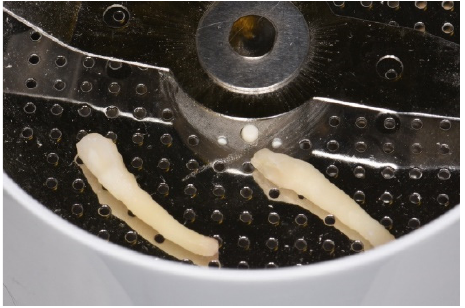
Figure 6. Grinding process of teeth with Kometabio Smart Dentin Grinder.